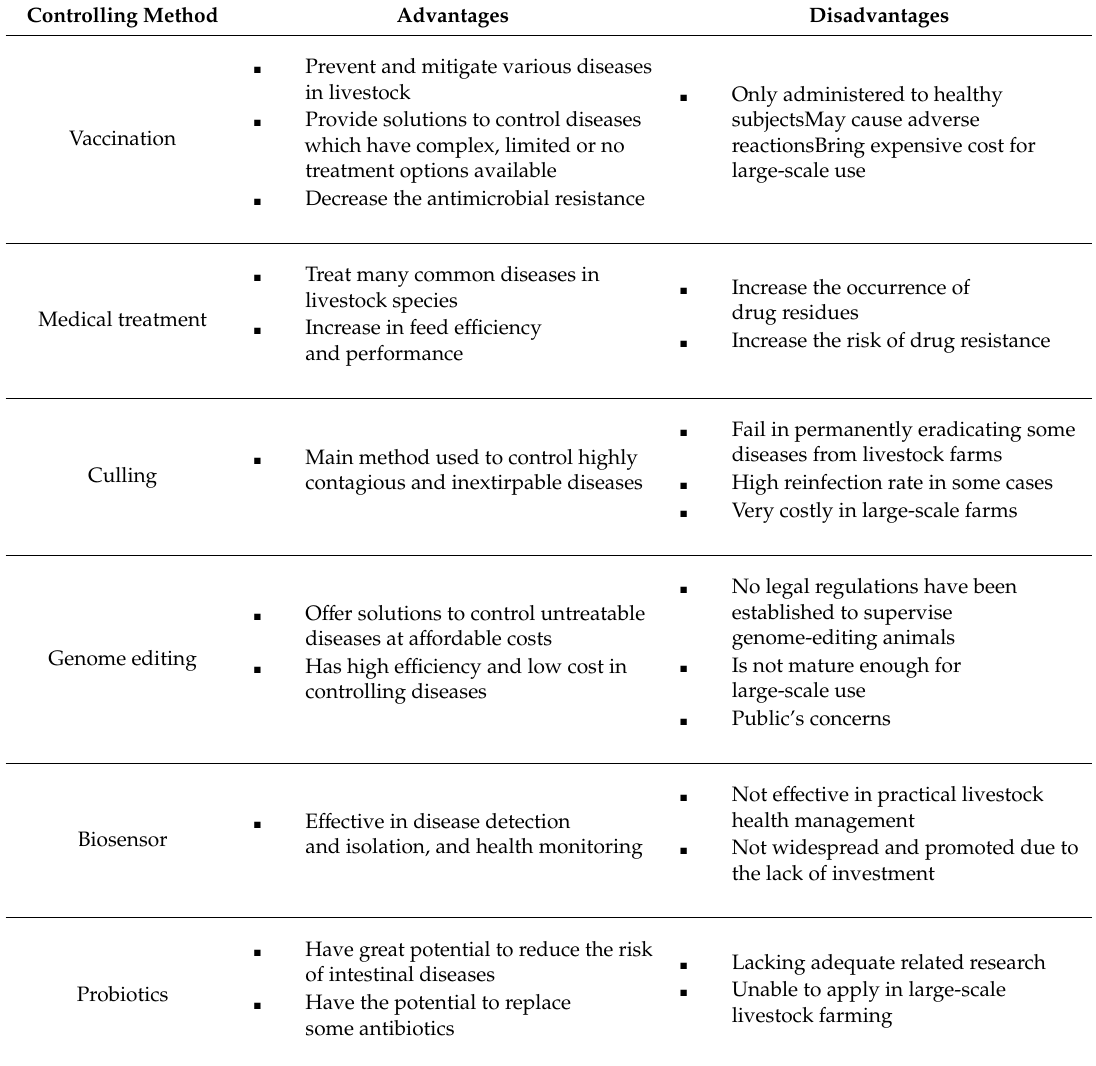
Table 2. Strengths and weaknesses of common non-selection disease control methods in farm